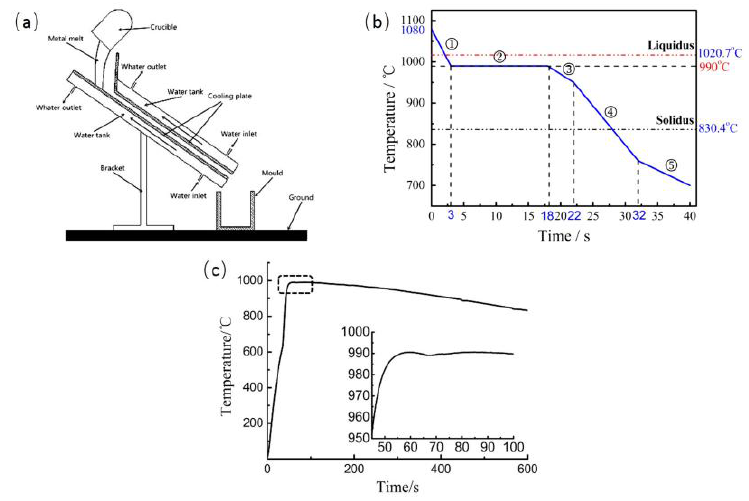
Figure 2. Schematic illustration of the: ( a ) ECSC equipment; ( b ) forming process curve; and ( c ) temperature recording curve during slurry transfer ① ECSC process, ② slurry transfer, ③ mold filling, ④ holding pressure, ⑤ parts air cooling.